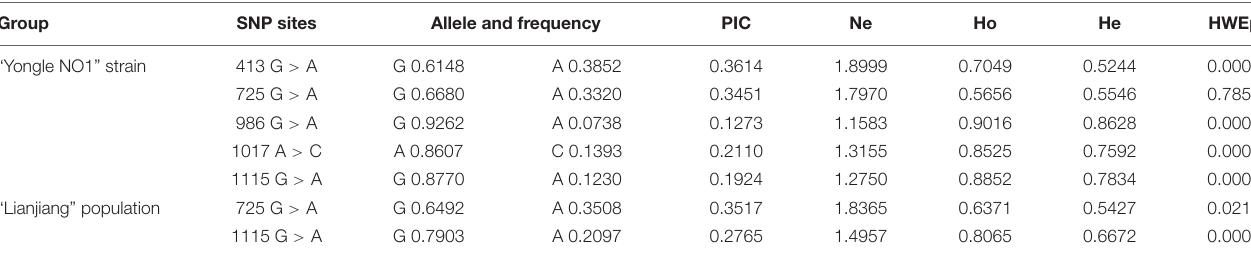
TABLE 3 | Analysis of association between SNPs and growth traits in two groups.